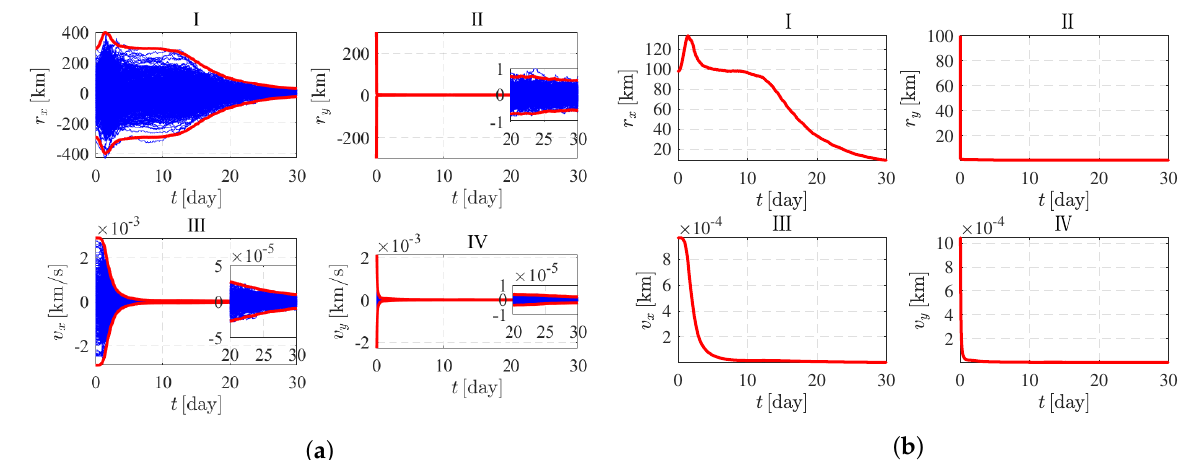
Figure 12. Results of the Monte Carlo simulation of the 2th orbital period. ( a ) 500 times shooting results. ( b ) 3-sigma